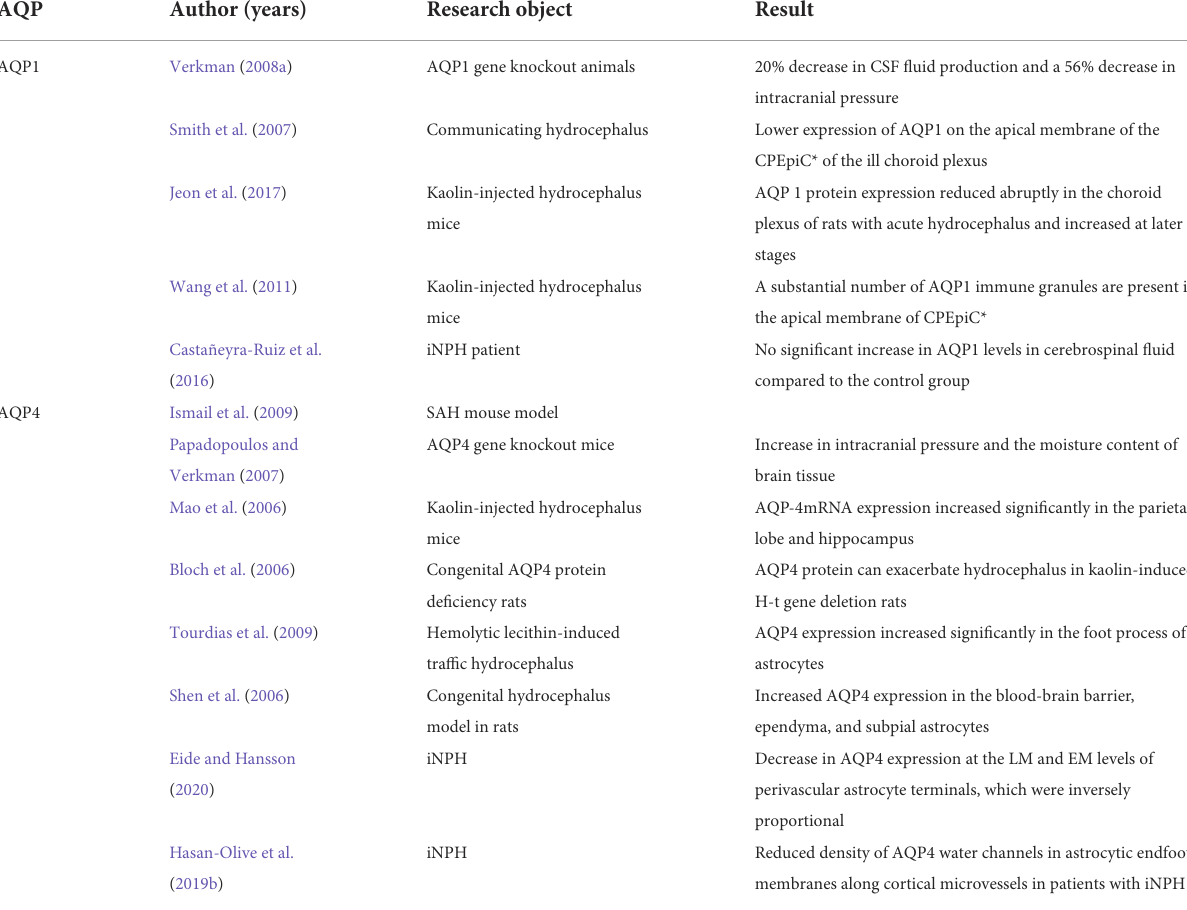
TABLE 1 Main studies investigating AQP1 and AQP4 in